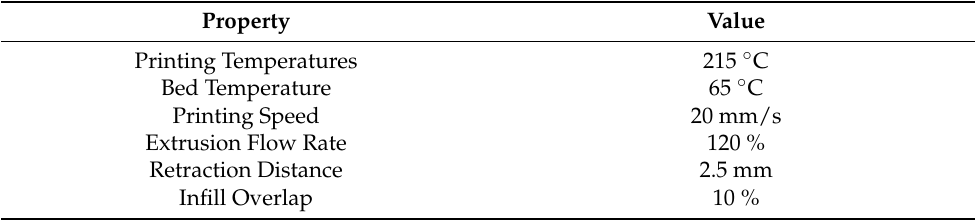
Table 2. Printing parameters for Recreus